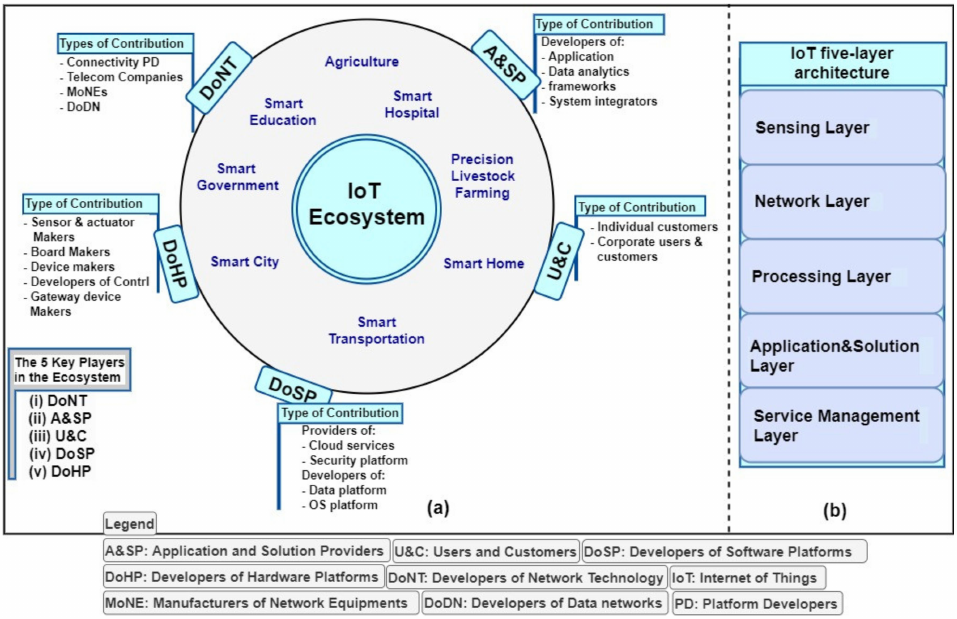
Figure 2. ( a ) A typical IoT ecosystem with ( b )